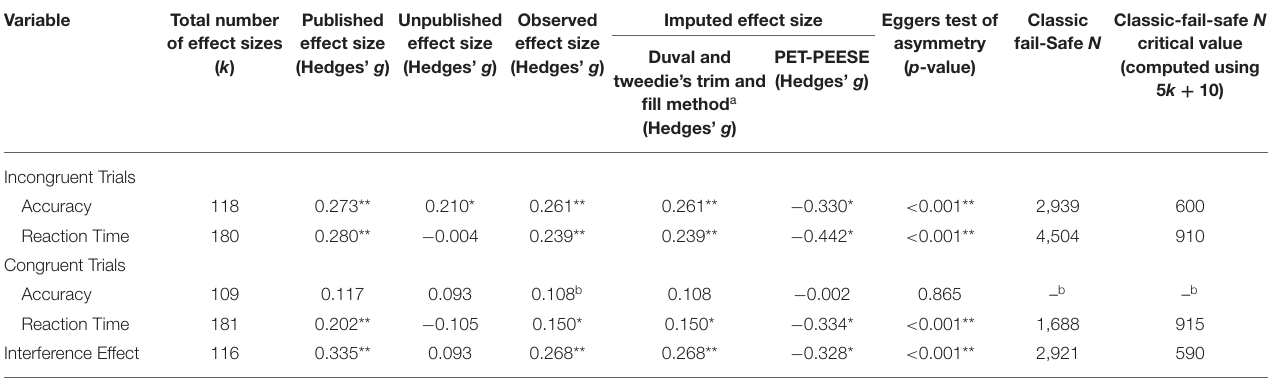
TABLE 5 | Results from Analyses of Publication Bias.